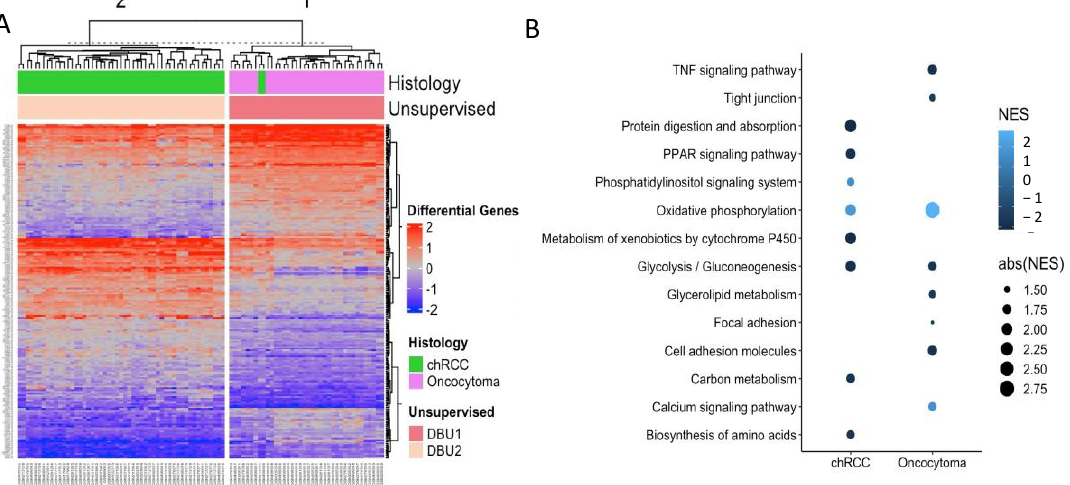
Figure 5. Molecular and pathway analysis: ( A ) top 194 Differentially expressed genes (candidate genes) between chRCC and RO. Genes are presented in rows and arrays are in columns; ( B ) bubble plot showing top upregulated pathways in chRCC and RO (x-axes) when compared to normal kidney tissue from gene set enrichment analysis for canonical pathways for differentially expressed genes. Y-axes represent different canonical pathways and size of the bubble represents normalized enrichment score.